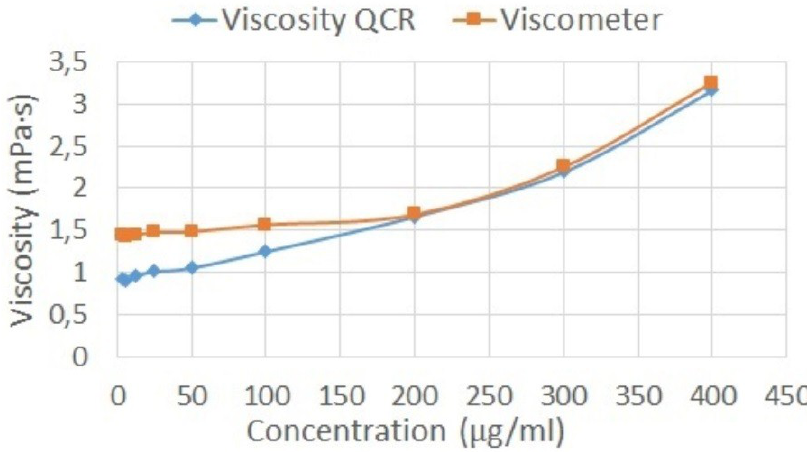
Figure 6. QCR biosensor performance vs. Fungilab viscometer